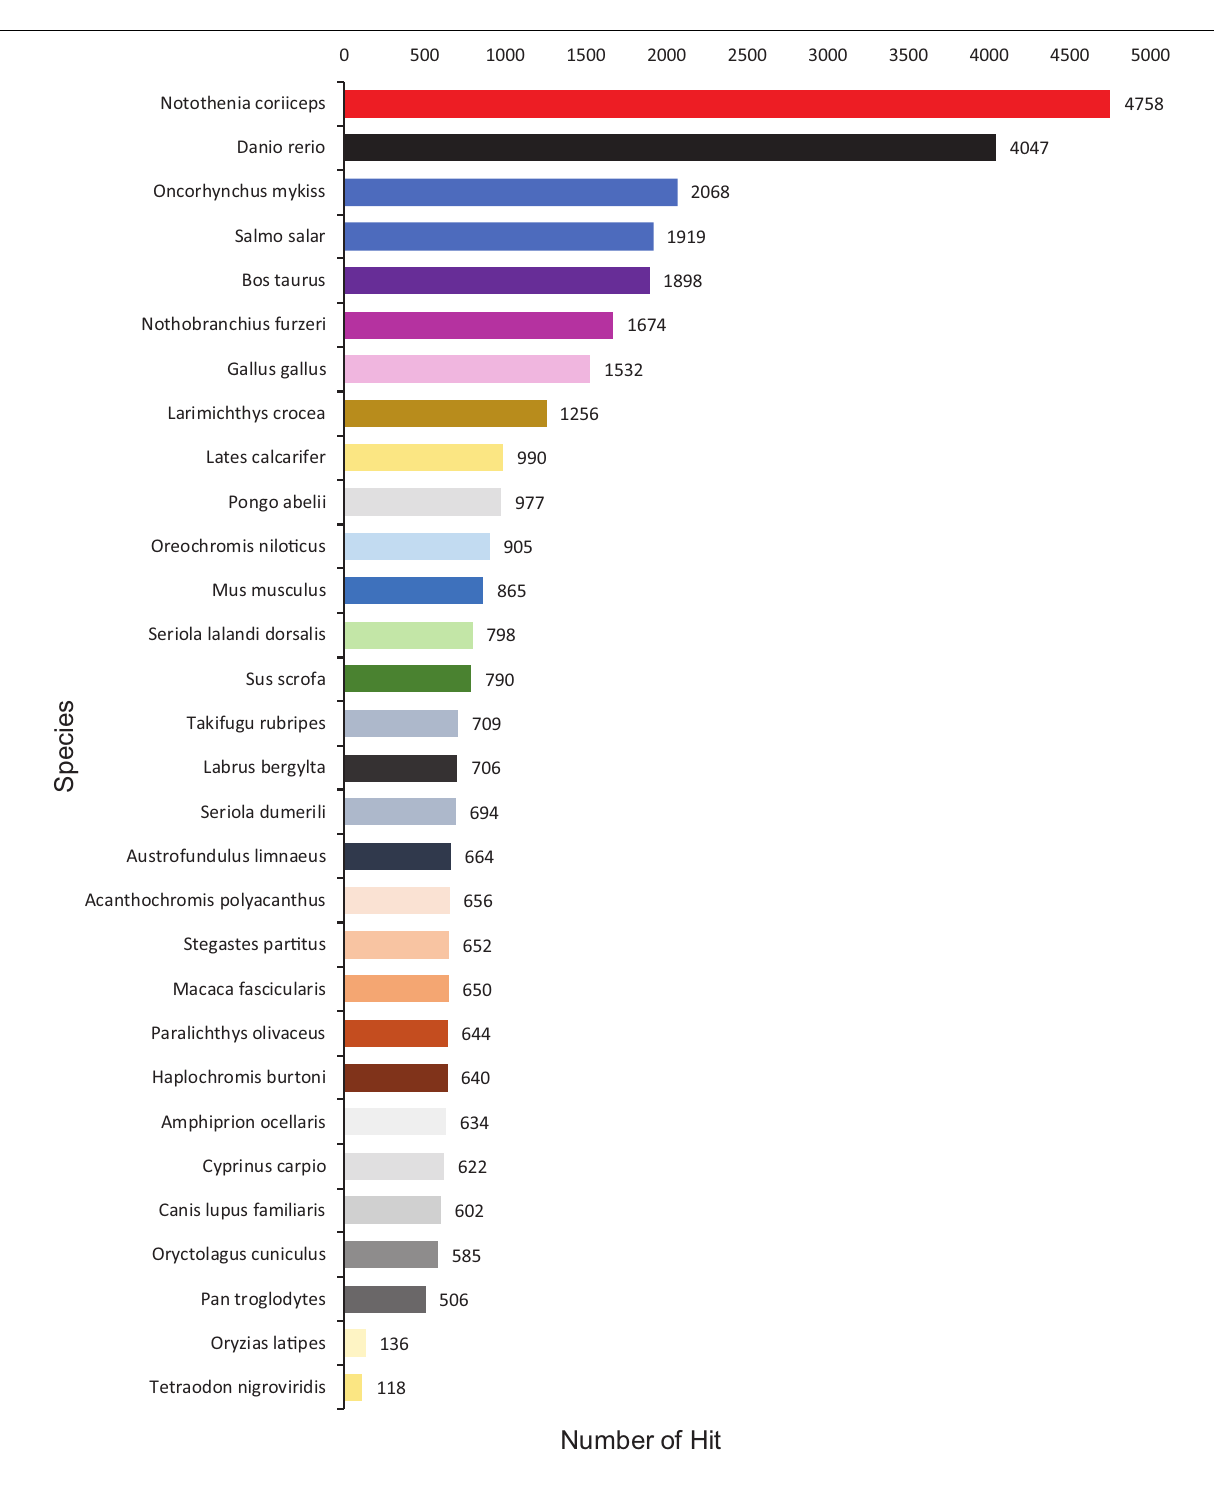
tissue/pair heart/muscle and gills/kidney share a similar pattern of gene expression. The liver and spleen seem to be the tissue with the gene expression profiles more differentiated ( Figure 3